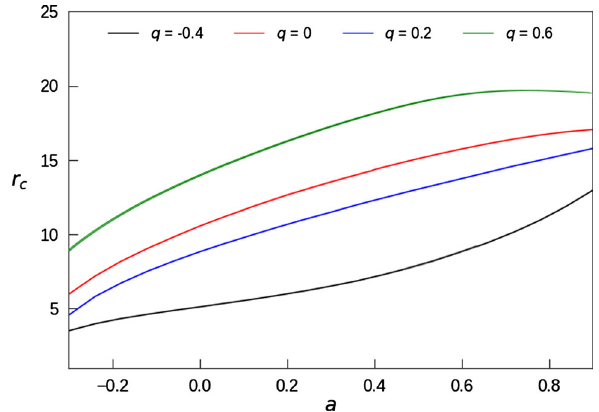
Fig. 7 The variation of the position of the center of the disk as a func- tion of